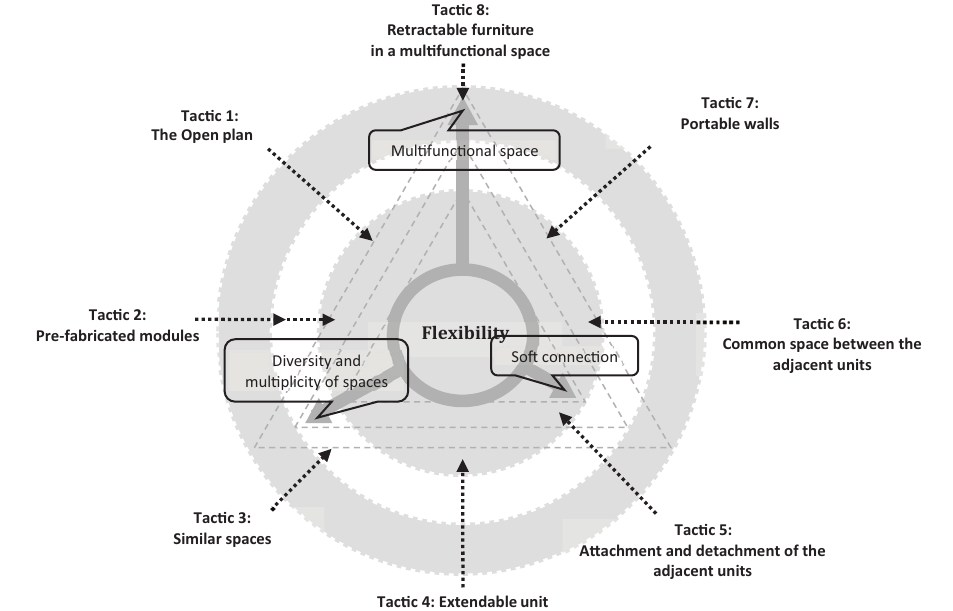
Figure 5. The convergent model of the principles and tactics of